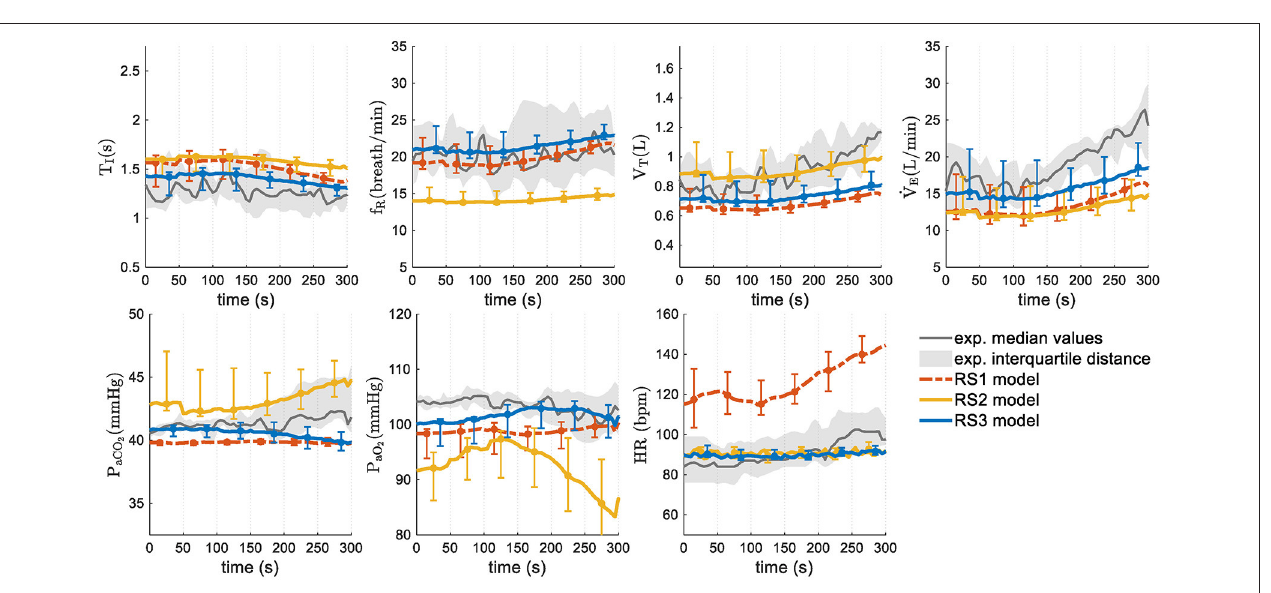
FIGURE 8 | Transient responses of models analyzed in this study. Median values and interquartile distance of experimental and simulated data are presented for each variable and model. Gray shadows show the IQR of experimental data and error bars the IQR of simulated data obtained by each